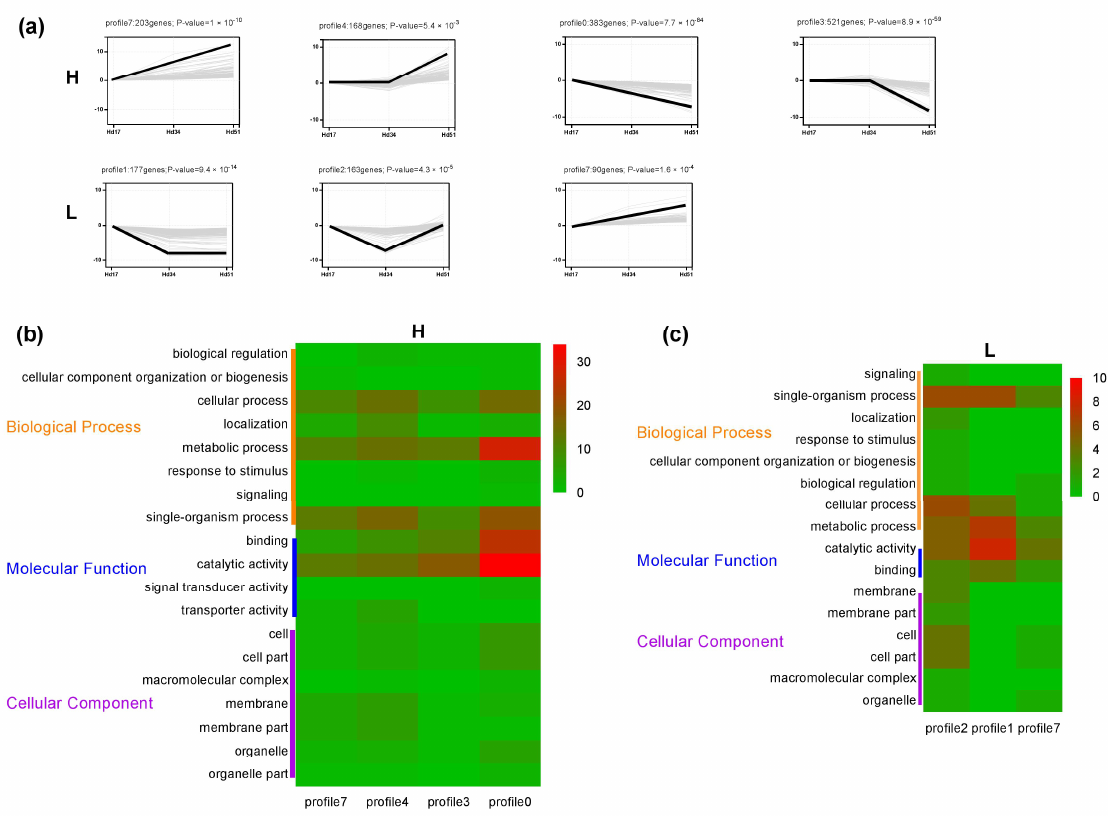
Figure 3. Patterns of gene expressions and analysis of Gene Ontology (GO) enrichment difference of the two strains. ( a ) In each pattern box, the thin gray line represents a gene expressing in this pattern, and the thick black line represents the expression trend of all genes in this pattern. The number of genes for this pattern and its p -value are marked on the pattern box. ( b ) Result of GO enrichment of genes of four significantly expressed patterns in high-yielding strains. ( c ) Result of GO enrichment of genes of three significantly expressed patterns in low-yielding strains. The number of genes in each group is represented by color; red means more genes and green means fewer genes.